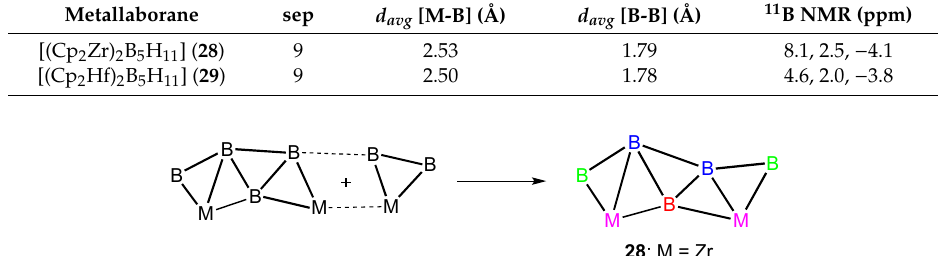
Table 6. Skeletal electron pair count (sep), selected structural parameters, and 11 B chemical shifts of 28 and 29 .